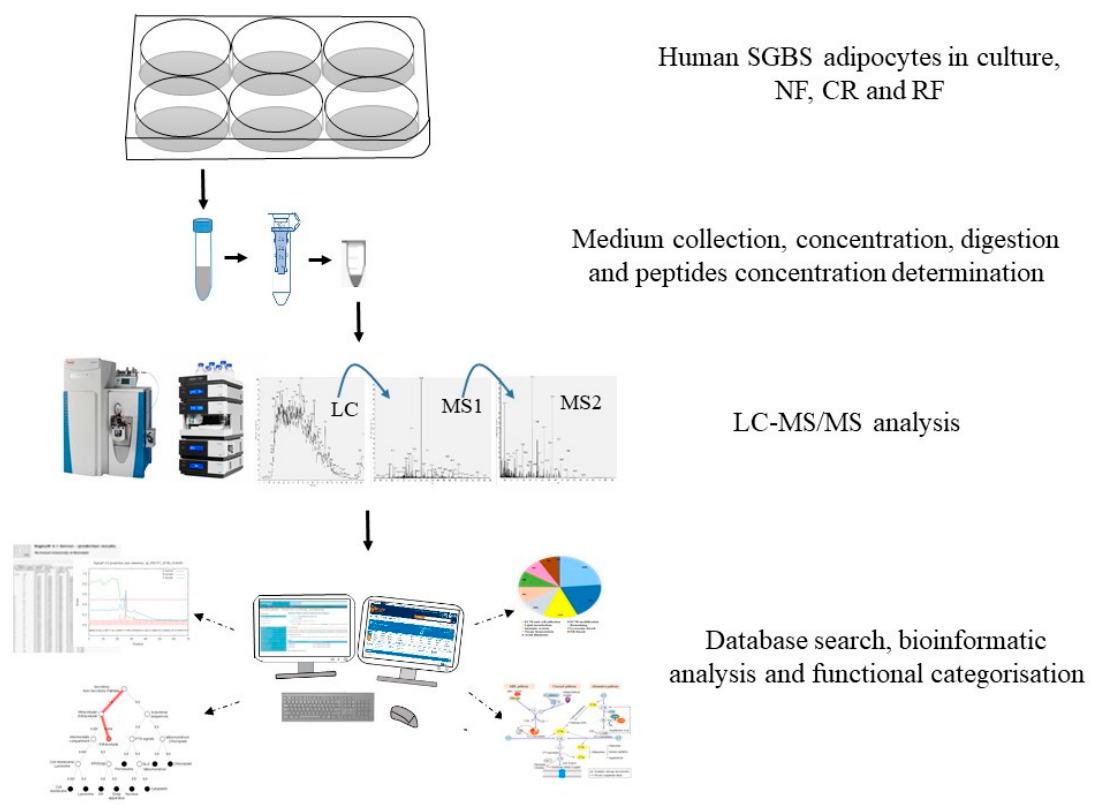
Figure 3. Workflow of the secretome profiling. Firstly, human SGBS adipocytes were cultured and after NF, GR and RF, medium was collected for all the time points. After sample preparation, proteins were identified and quantified by LC-MS / MS. Finally, bioinformatic and statistic analysis were performed for functional interpretation. NF: normal feeding, GR: glucose restriction, RF: refeeding.